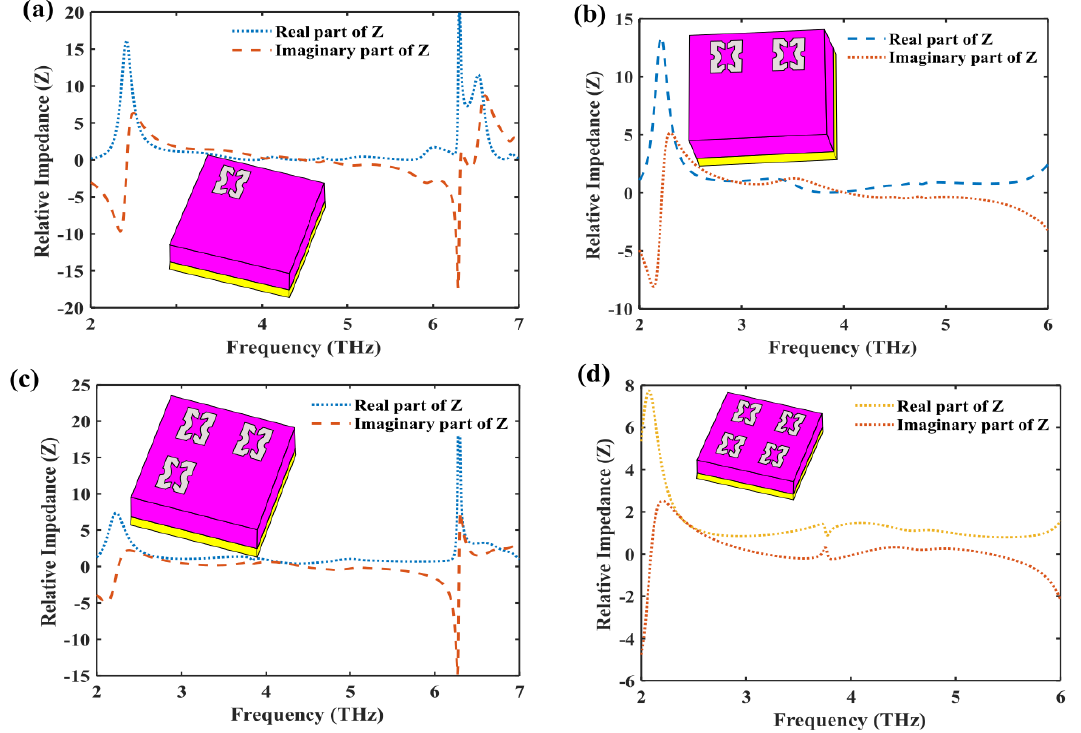
Figure 10. Relative impedance of the design steps ( a ) with a single arc-shaped VO 2 patch on top; ( b ) with a two-arc VO 2 pattern on top; ( c ) with a three-arc VO 2 pattern on top; ( d ) with four equal arc-shaped VO 2 patterns positioned diagonally on the top.